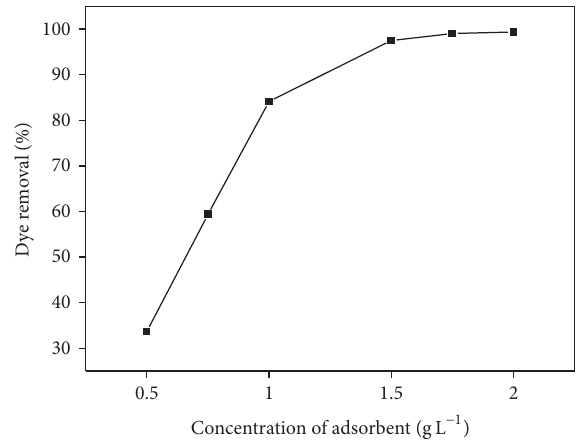
F 2: Effect of adsorbent concentration on MB adsorption (